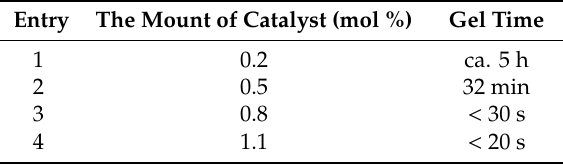
Table 1. The gel time versus catalyst amount for the preparation of